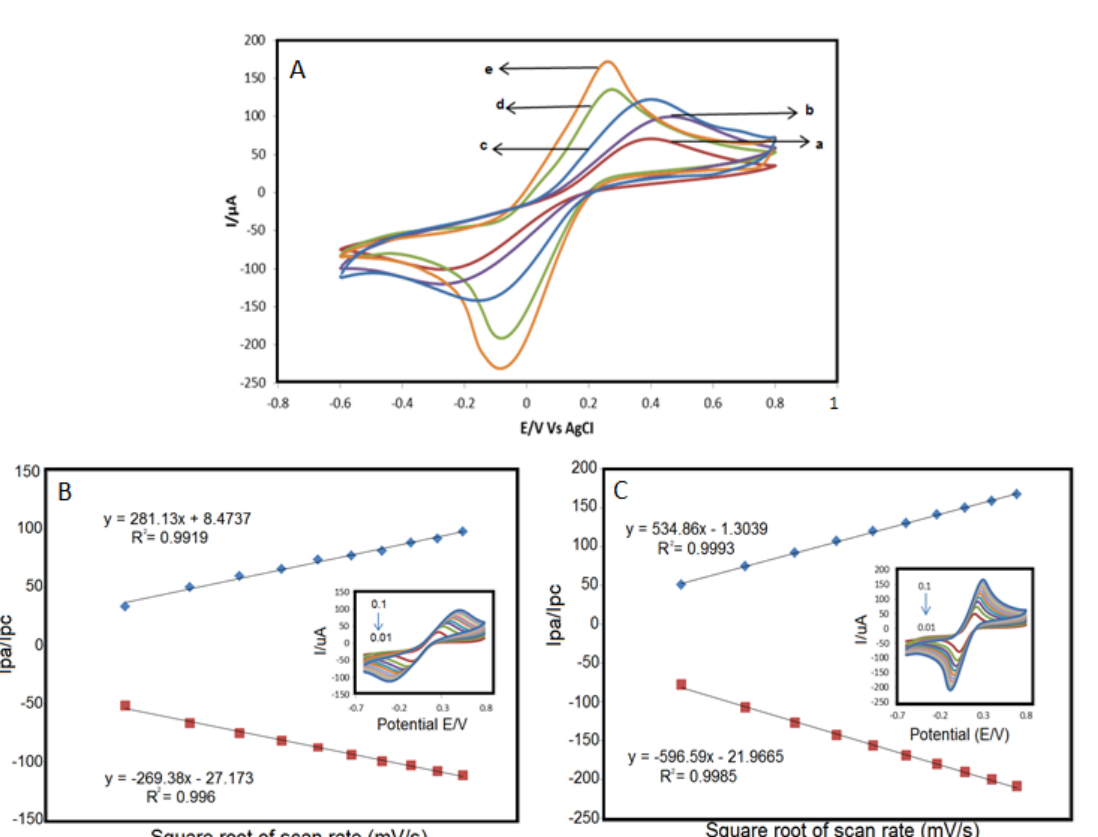
Figure 2. Cyclic voltammograms behavior: ( A ) (a) bare SPCE, (b) SPCE/Fe 3 O 4 , (c) SPCE/MPA-Fe 3 O 4 , (d) SPCE/NCC/CTAB and (e) SPCE/MPA-Fe 3 O 4/ NCC/CTAB in 5.0 mM K 3 Fe(CN) 6 /0.1 M KCI with scan rate, 100 mV/s; ( B ) Plot of anodic and cathodic peak current (Ip) vs. square root of scan rate (V 1/2) of bare SPCE, and; ( C ) SPCE/MPA-Fe 3 O 4 /NCC/CTAB.